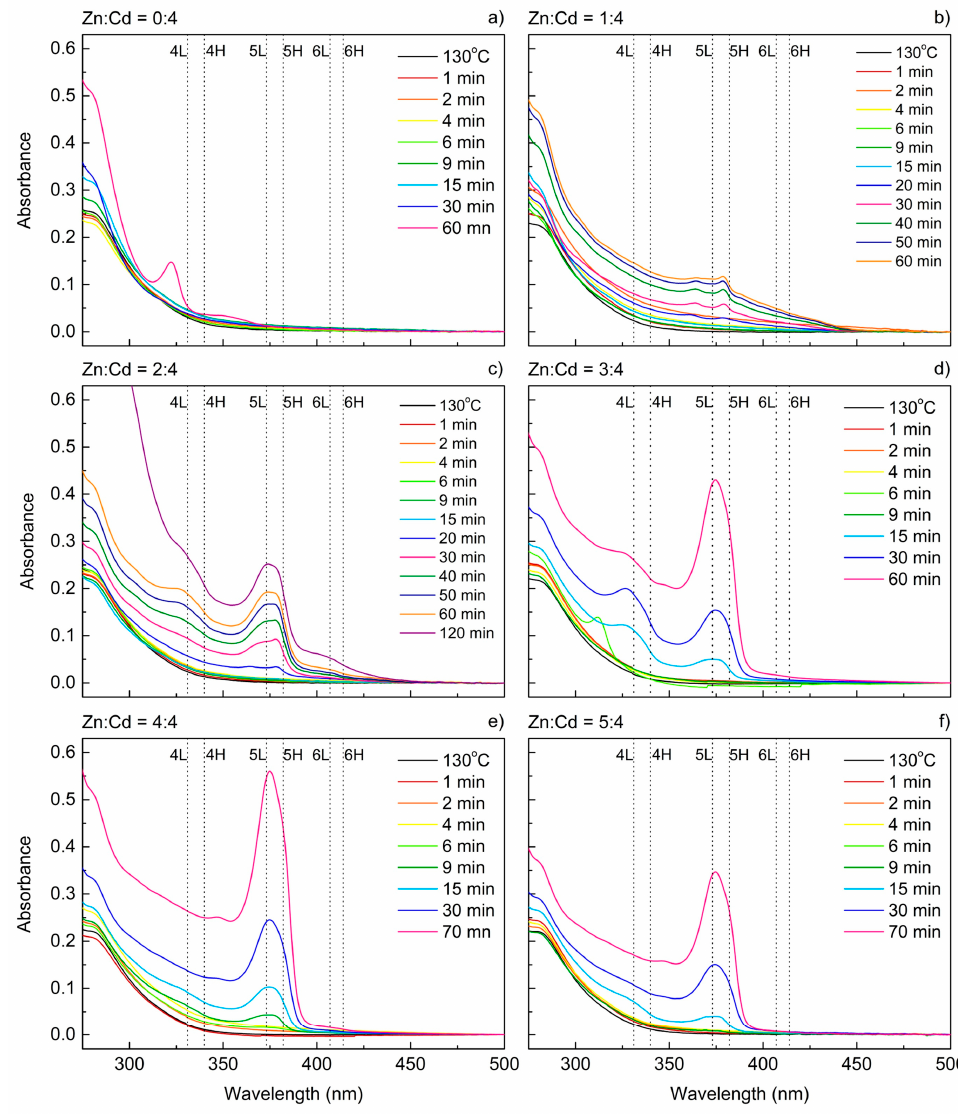
Figure 2. Absorbance spectra of cadmium sulfide (CdS) nanocrystals obtained with different Zn(Ac) 2 concentrations recorded for aliquots taken at different stages of the reaction. The Zn:Cd ratio is indicated on top of every graph: ( a ) Zn:Cd = 0:4; ( b ) Zn:Cd = 1:4; ( c ) Zn:Cd = 2:4; ( d ) Zn:Cd = 3:4; ( e ) Zn:Cd = 4:4; ( f ) Zn:Cd = 5:4. The reaction temperature for all samples was 180 ◦ C except 130 ◦ C for the first aliquots. The electron-light hole (L) and electron-heavy hole (H) transitions for 4, 5, and 6 ML platelets are marked with dotted lines based on Reference